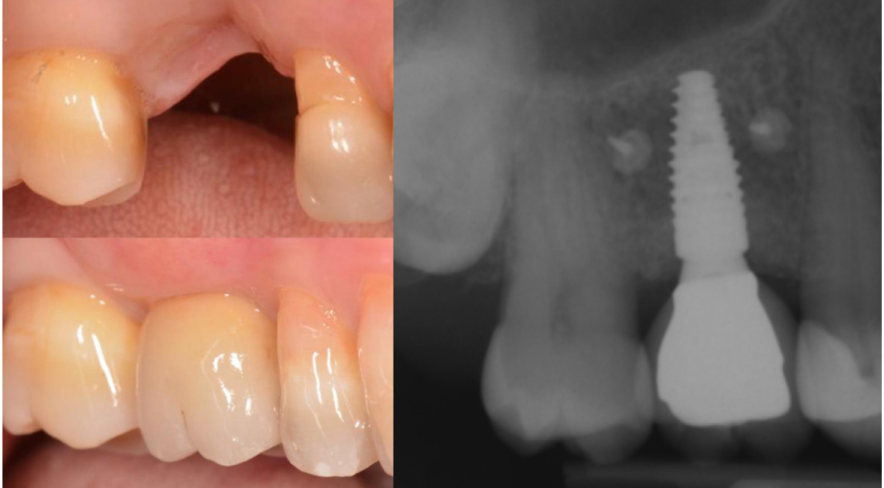
Figure 12. Baseline and clinical and radiographic result 36 months after loading.